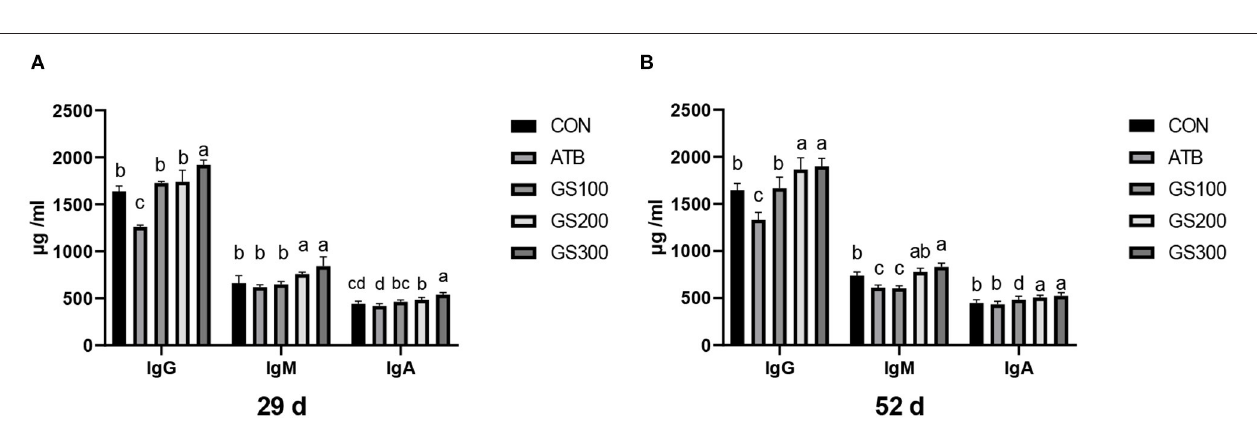
FIGURE 8 | Effects of ginsenoside Rg1 on serum immunoglobulins at day 29 (A) and day 52 (B) in broiler chickens ( n = 6). CON, birds fed a basal diet; GS100, birds fed a basal diet supplemented with 100 mg/kg ginsenoside Rg1; GS200, birds fed a basal diet supplemented with 200 mg/kg ginsenoside Rg1; GS300, birds fed a basal diet supplemented with 300 mg/kg ginsenoside Rg1; ATB, a basal diet supplemented with 300 mg/kg chlortetracycline. Data were shown as means ± standard deviations. Mean value without the common letter on the data bar in each figure indicated that the difference was significant ( P <